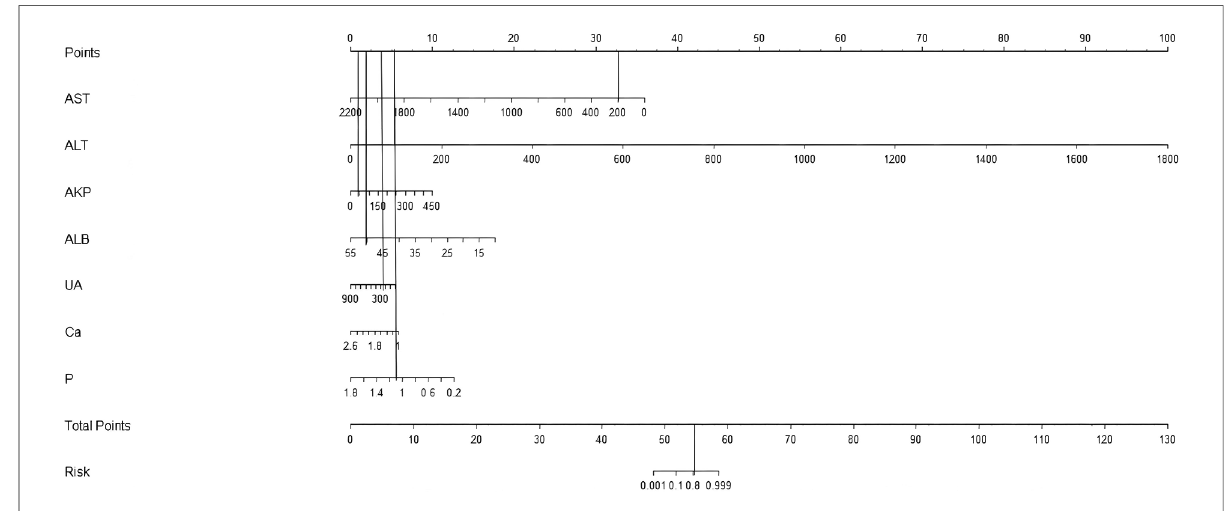
FIGURE 2 Application of nomogram prediction model for Wilson ’ s